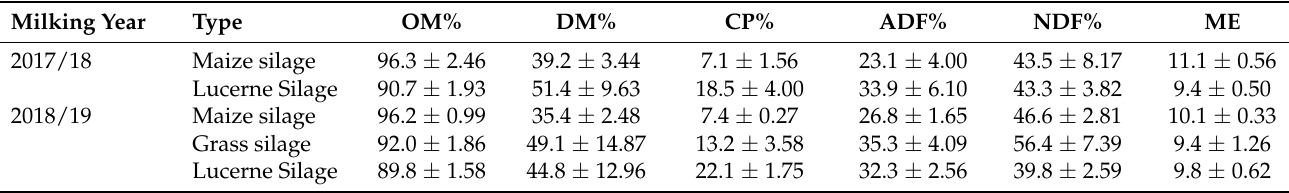
Table 1. Dry matter (DM) %, organic matter (OM), crude protein (CP), acid detergent fibre (ADF) and neutral detergent fibre (NDF) % in DM, and metabolisable energy (ME; MJ/kg DM) of supplement fed to cows during 2017/18 and 2018/19 milking year. Mean ±